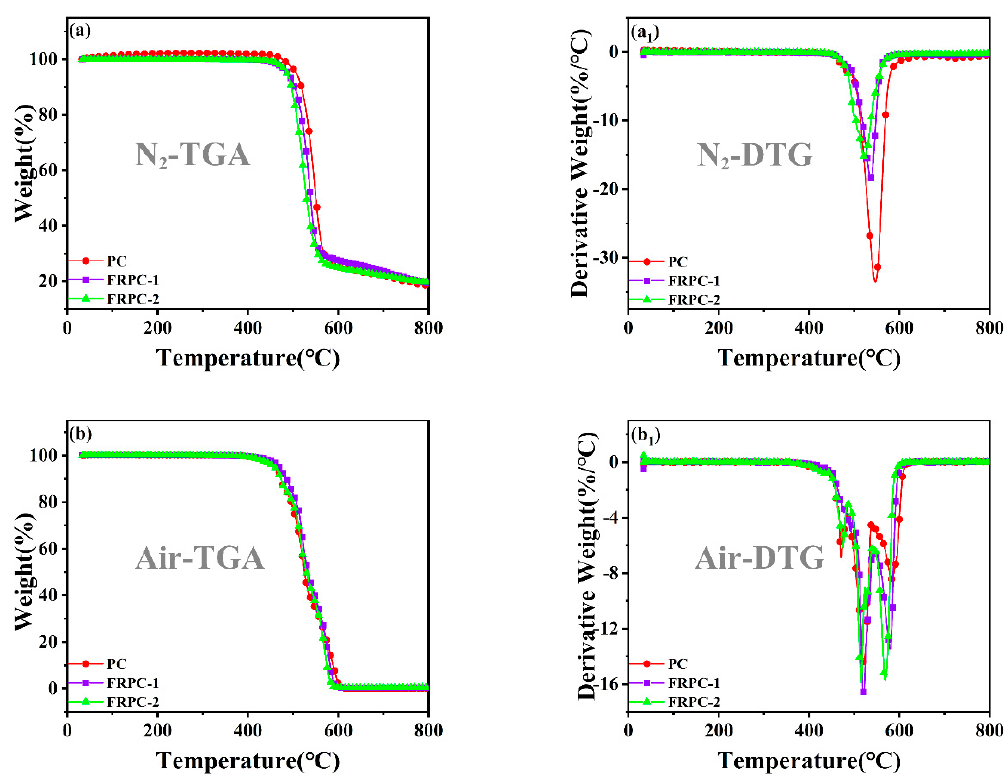
Figure 1. TGA and DTG curves of PC and FRPCs under N 2 ( a , a 1 ) and air ( b , b 1 ). Table 2. Thermal parameters for PC and FRPCs.